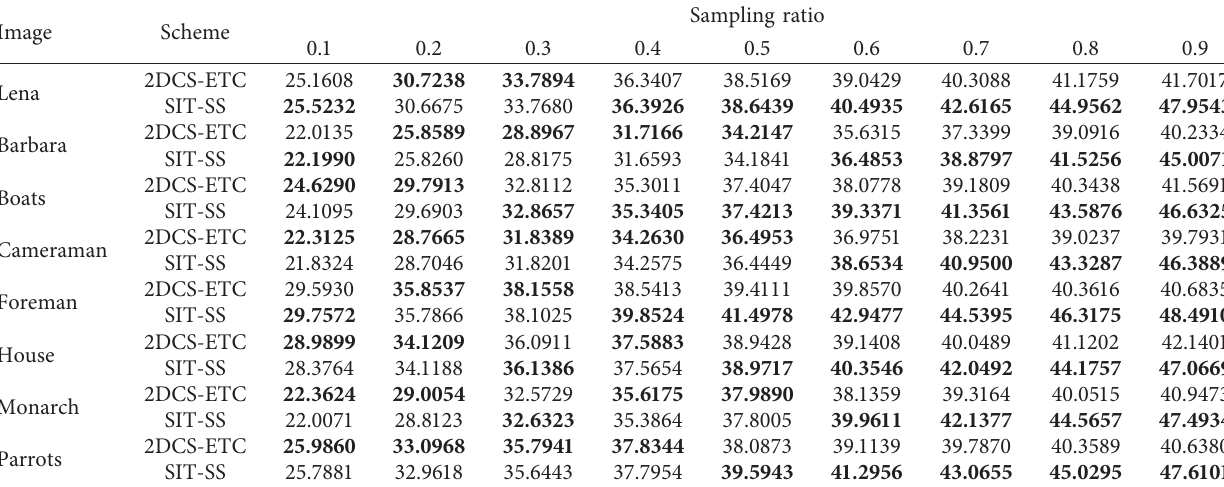
Table 3: PSNR (dB) of 2DCS-ETC and SIT-SS under different sampling